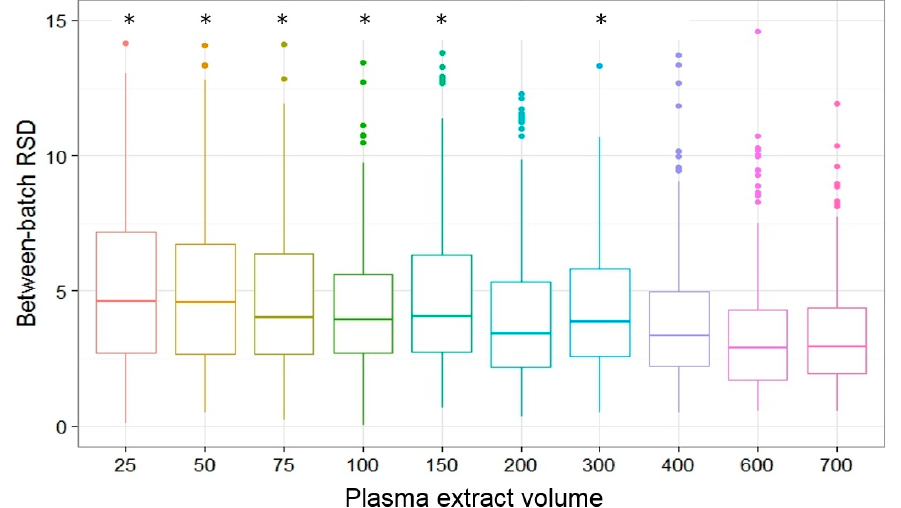
Figure 4. Boxplot of intermediate precision (between-batch relative standard deviation or RSD) by plasma extract volume. The horizontal lines represent the median and the lower and upper hinges correspond to the 25th and 75th percentiles. The asterisks * denote RSD that was significantly different in post-hoc pairwise comparisons using the Conover’s test for multiple comparisons.